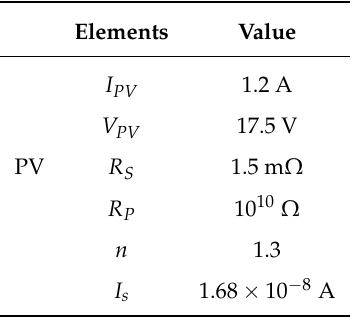
Table 1. Parameters of the PV modules.